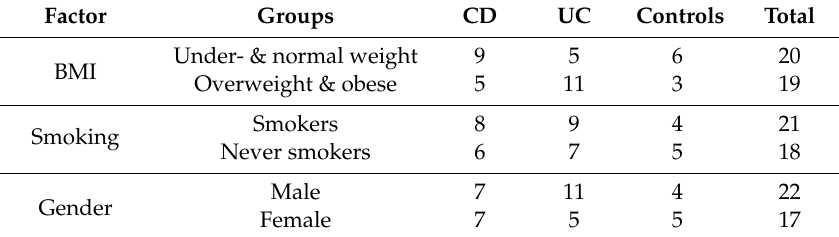
Table 3. Summary of confounding factor